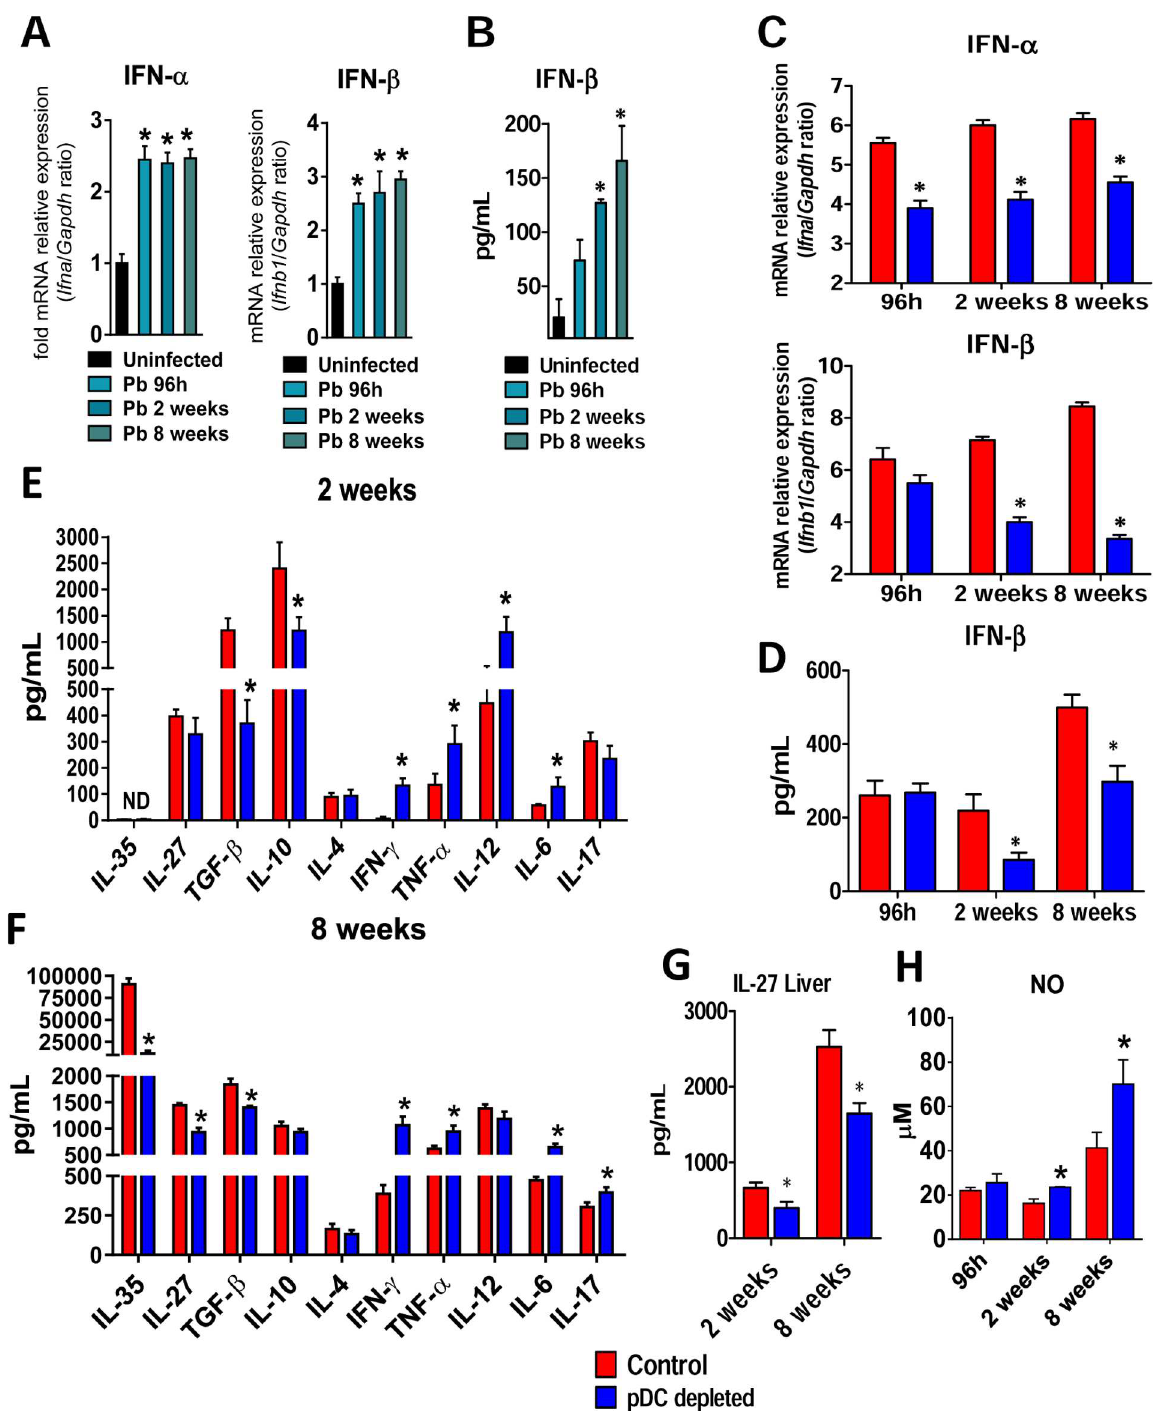
Fig 3. pDC-depletion reduces the mRNA expressionof type I IFNs, secretedIFN- β and anti-inflammatory cytokines but increases the production of pro-inflammatory cytokines. (A) Expression of IFN- α and IFN- β mRNA in the lungs of uninfectedor P . brasiliensis infected mice after 96 h, 2 and 8 weeks of infection. (B) Type I IFN quantitationby ELISA in lung homogenates from uninfectedand infected mice at the same post-infection periods. (C) mRNA relativeexpressionof IFN- α and IFN- β in the lungs of anti- PDCA or control isotype mAb treated mice. (D) Type I IFN quantitation by ELISA in lung homogenates from pDC-depleted or control mice. (E-F) Cytokines quantitationby ELISA in lung homogenates from pDC-depletedor control mice at weeks 2 and 8 after infection. (G) IL-27 quantitationby ELISA in liver homogenates from pDC-depleted or control mice. (H) Supernatants of lung homogenates